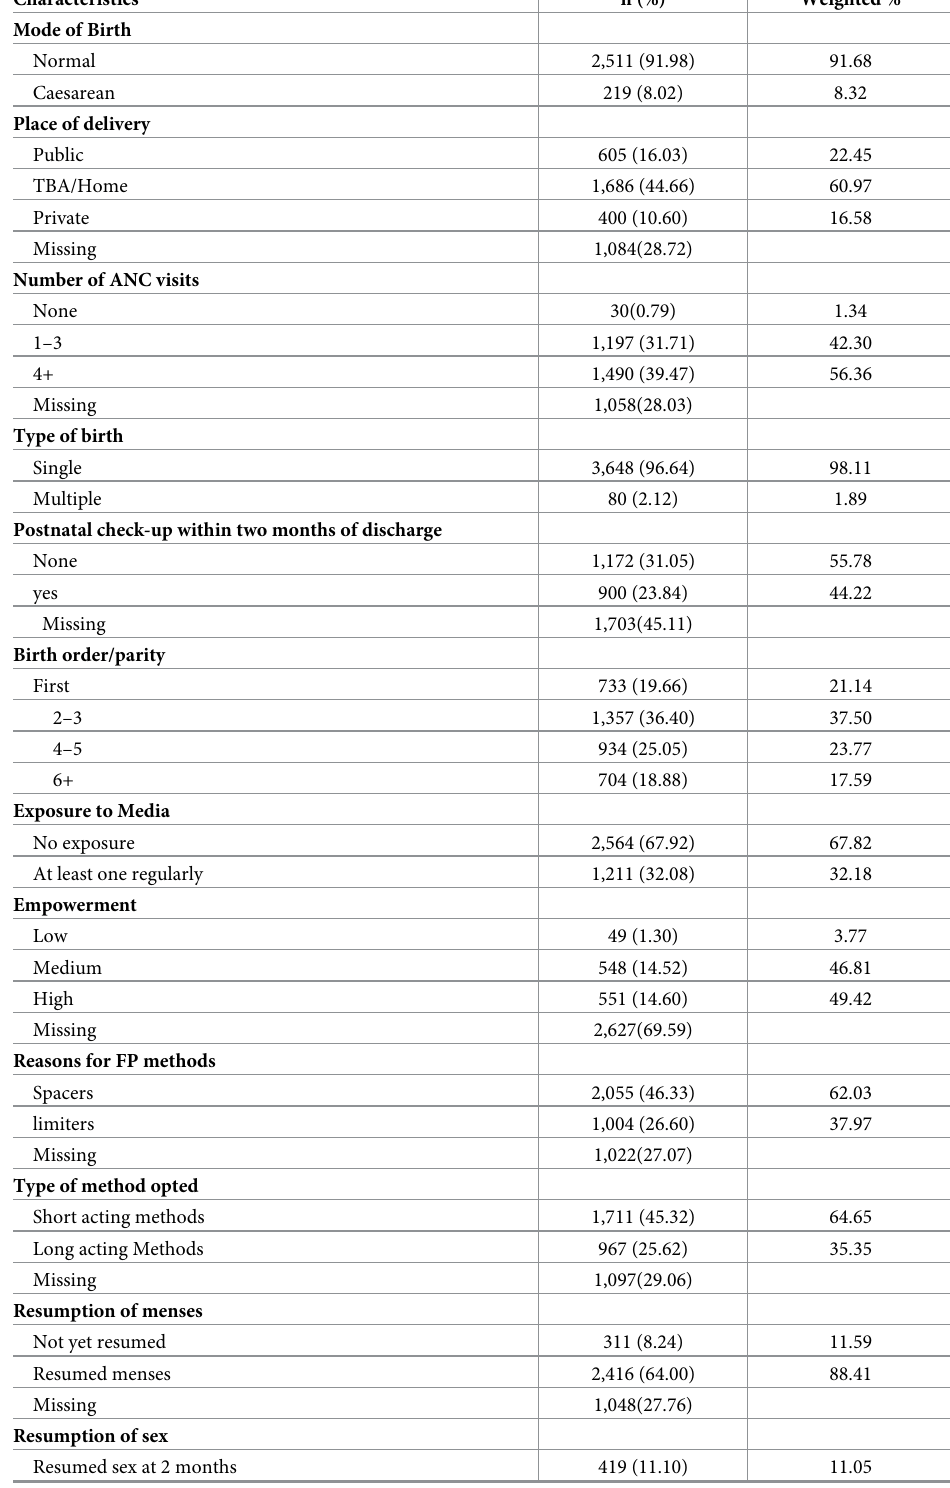
Table 2. Reproductive characteristics of the study participants (N =